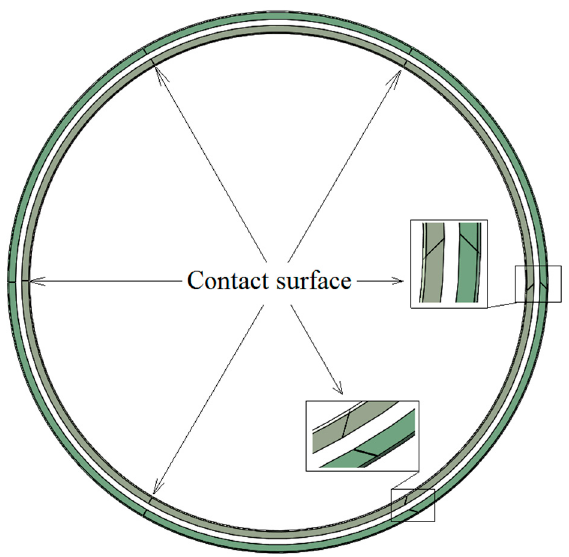
Figure 4. Design of internal inner and external inner.